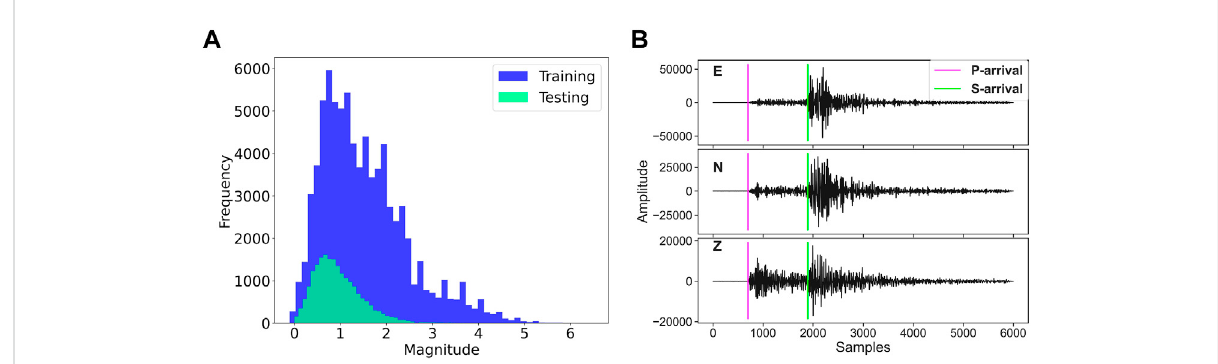
FIGURE 2 Data visualization in the analysis. (A) shows the frequency – magnitude distributions of earthquake events in the training dataset. (B) gives an example of a seismic data (Mousavi et al., 2019), where the plots in the fi gure from the top to the bottom represent the three-component seismic recordings (including east – west, north – south, and vertical directions), respectively. In (B) , the colored vertical lines denote the fi rst arrival times of picked P and S phases from the earthquake catalog, respectively.